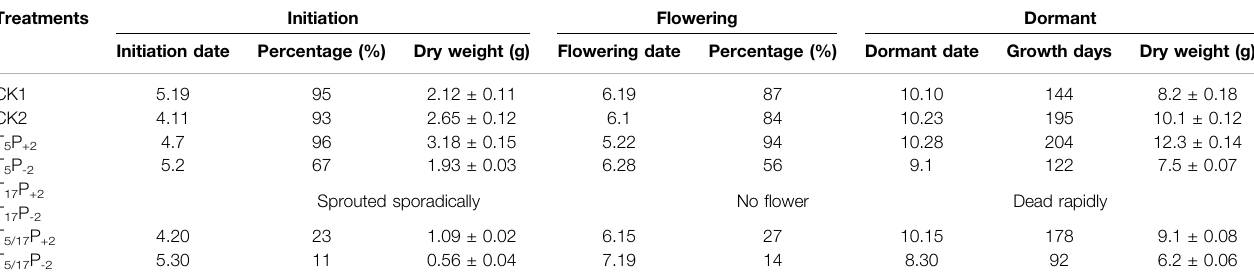
TABLE 4 | Effects of temperature and photoperiod on phenology and biomass of American ginseng. Treatments